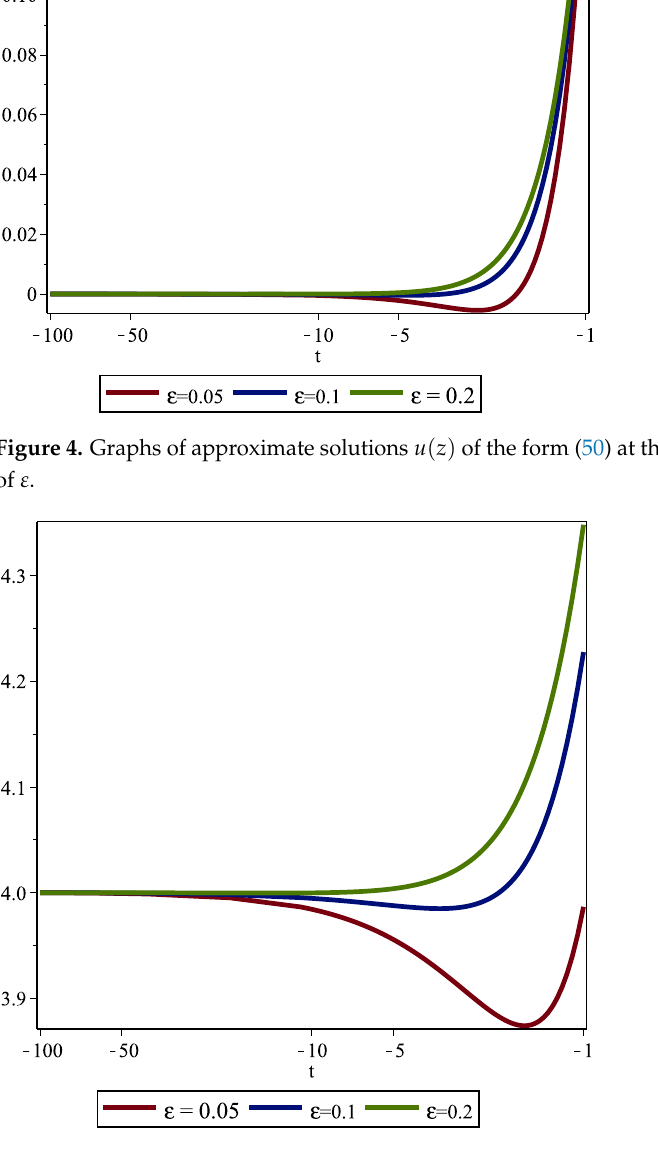
Figure 5. Graphs of approximate solutions v ( z ) of the form (50) at the point x = 1 for different values of ε